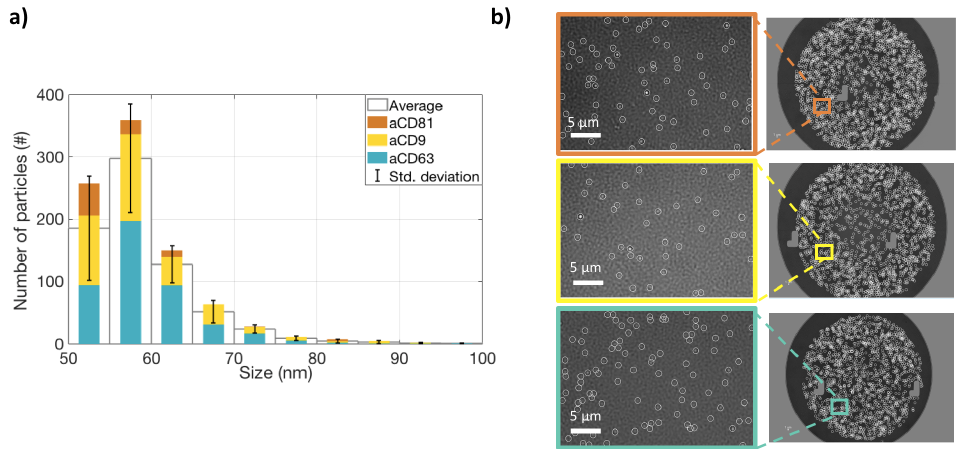
Figure 1. Label-free measurements of extracelluralar vesicles’ (EVs’ )shape and size distribution. ( a ) The size distribution of EVs captured on CD9, CD81, and CD63 spots. The colored bars represent the number of particles counted on each antibody spot. The white bars represent the average of the three antibodies, and the black lines show the standard deviation. ( b ) Label-free images of the particles on the three